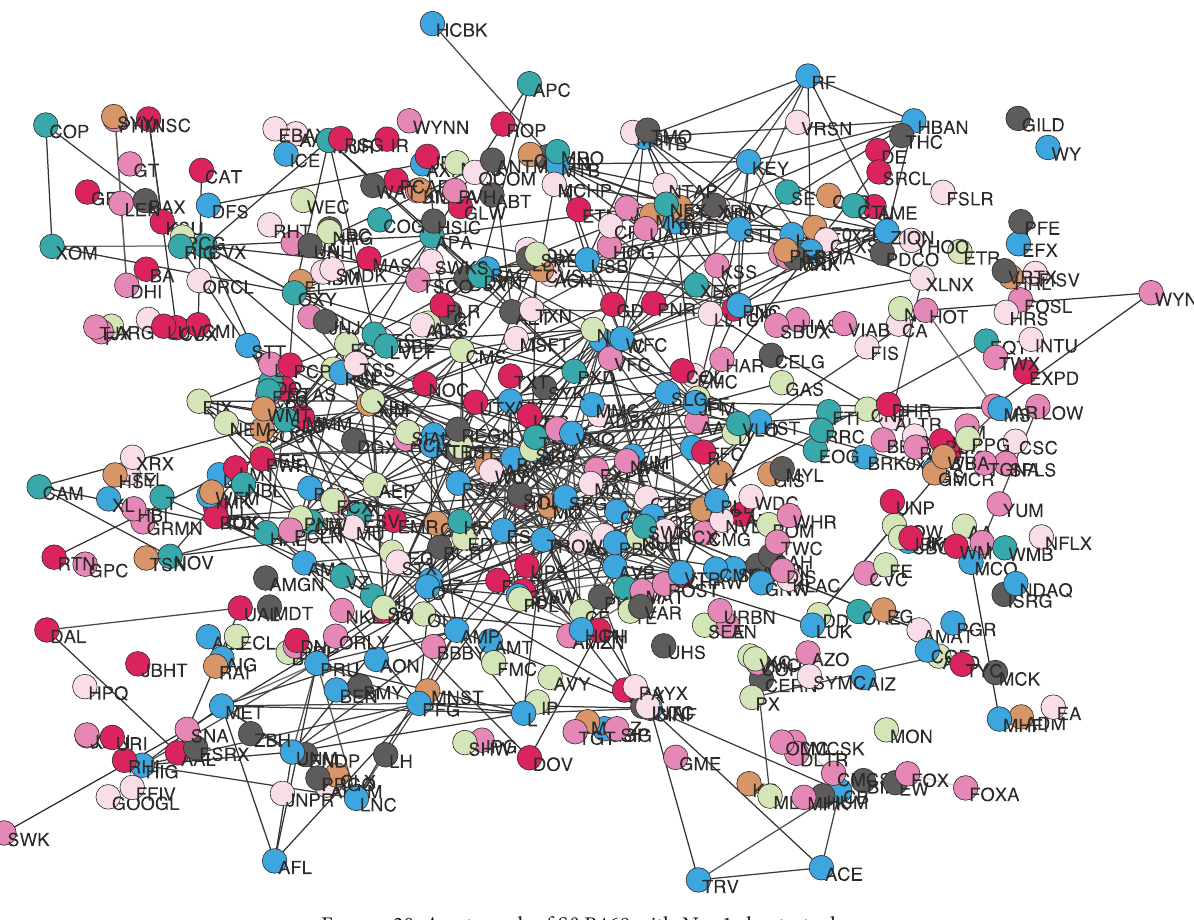
Figure 20: Asset graph of S&P468 with 𝑁 − 1 shortest edges.